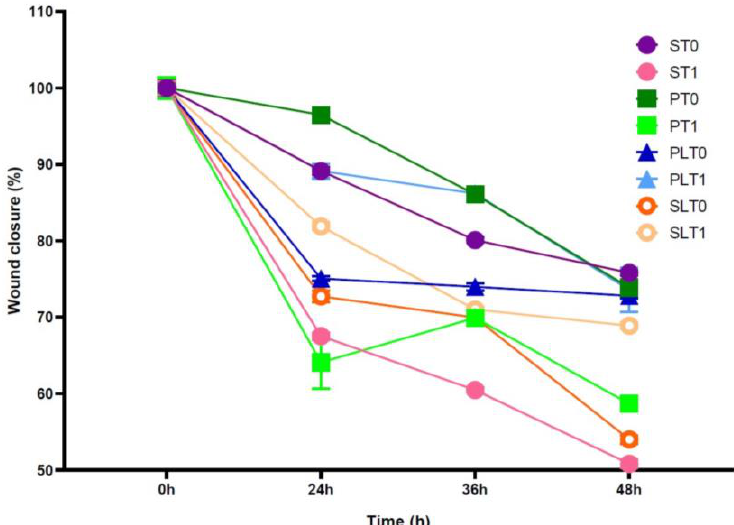
Figure 4. Cell migration ability was assessed via the wound-healing assay on the HCT-116 cell line. A quantitative representation of the wound distance measurement in µm is related to the time of treatment action. The data are represented as the mean +/ − standard deviation (n = 3). Study groups: TIVA with lidocaine (group PL, before surgery—T0 and after surgery—T1); TIVA (group P, before surgery—T0 and after surgery—T1); sevoflurane with lidocaine (group SL, before surgery—T0 and after surgery—T1); sevoflurane (group S, before surgery—T0 and after